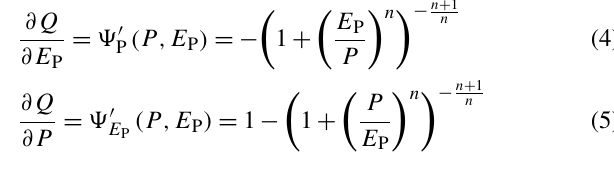
Figure 3. Elasticity graphs proposed by Wolock and Mc- Cabe